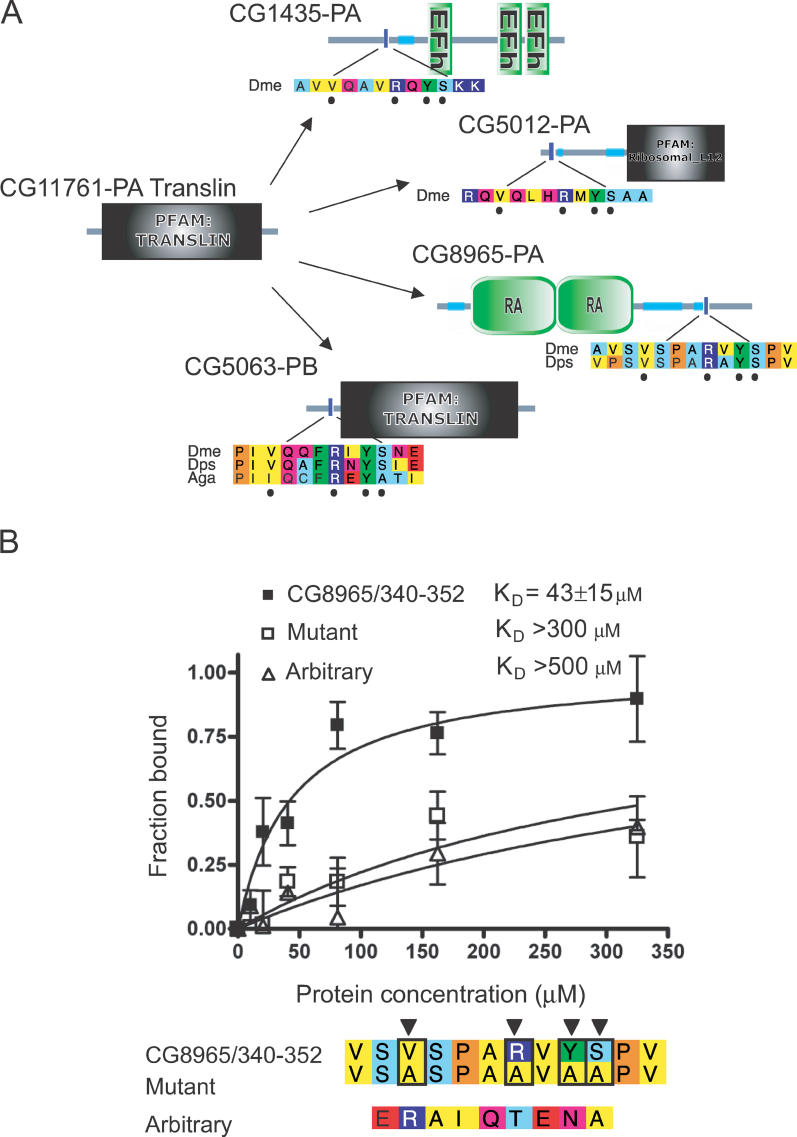
A Novel Fly VxxxRxYS Motif That Binds Translin(A) Translin (left) shown surrounded by interaction partners containing the predicted motif VxxxRxYS. Proteins are shown as lines with domains (labelled shapes), predicted coiled coils (light blue/green segments), and the location of motifs (blue vertical bars). Sequences for the motif-containing region are shown aligned to the best homologues in closely related species. Amino acids are coloured according to residue type: blue, positive; red, negative; light blue, small; yellow, hydrophobic; green, aromatic; magenta, polar; and orange, proline. Those constituting the predicted motif are denoted by circles. Aga, Anopheles gambiae; Dme, D. melanogaster; Dps, D. pseudoobscura.(B) Saturation curves, showing bound fraction (fluorescently labelled peptides at saturation) as a function of Translin concentration. Polarization values (mP) at zero concentration and Bmax were normalised to give the bound fraction. K
D was computed by non-linear regression on values from three independent experiments. The lower panel shows the alignment of the native and mutated peptides together with the arbitrary peptide (selected randomly). Black triangles show positions specifying the motif (VxxxRxYS). The alignment is coloured as described in (A).